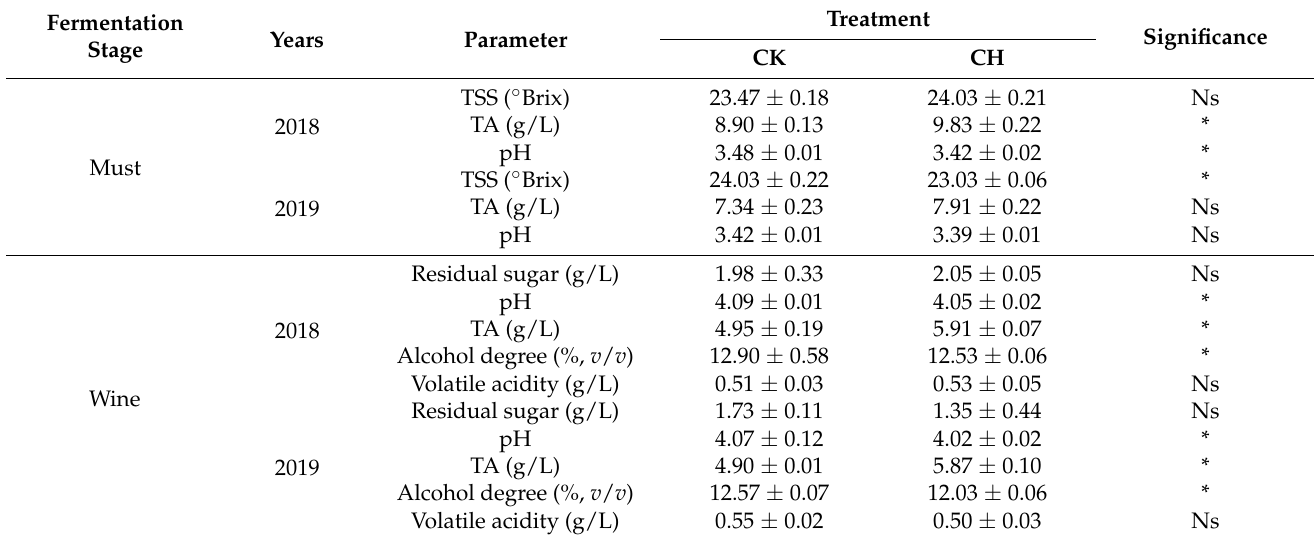
Table 1. Must and wine physicochemical parameters of the clean tillage (CK) and covering peanuts (CH).